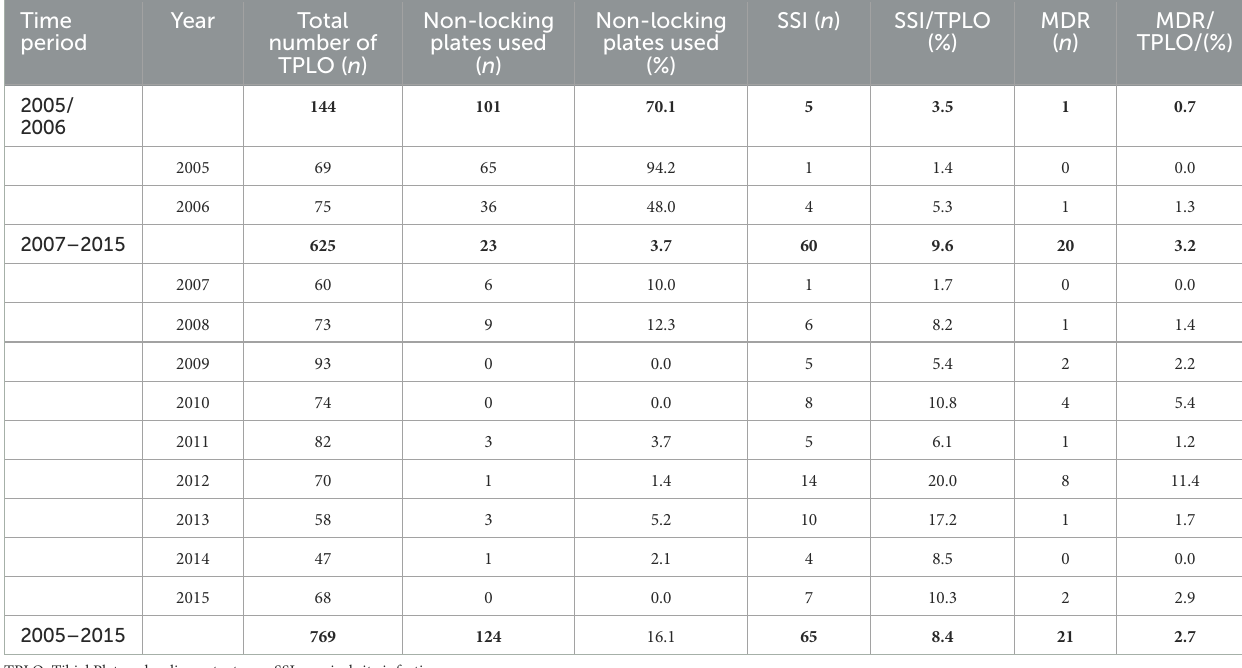
TABLE 2 Usage of non-locking implants, occurrence of SSI and isolation of MDR bacteria of 769 TPLO between 2005 and 2015.